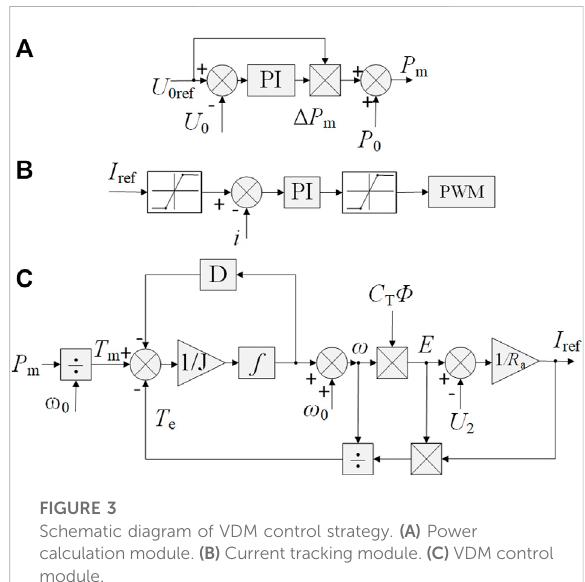
FIGURE 3 Schematic diagram of VDM control strategy. (A) Power calculation module. (B) Current tracking module. (C) VDM control